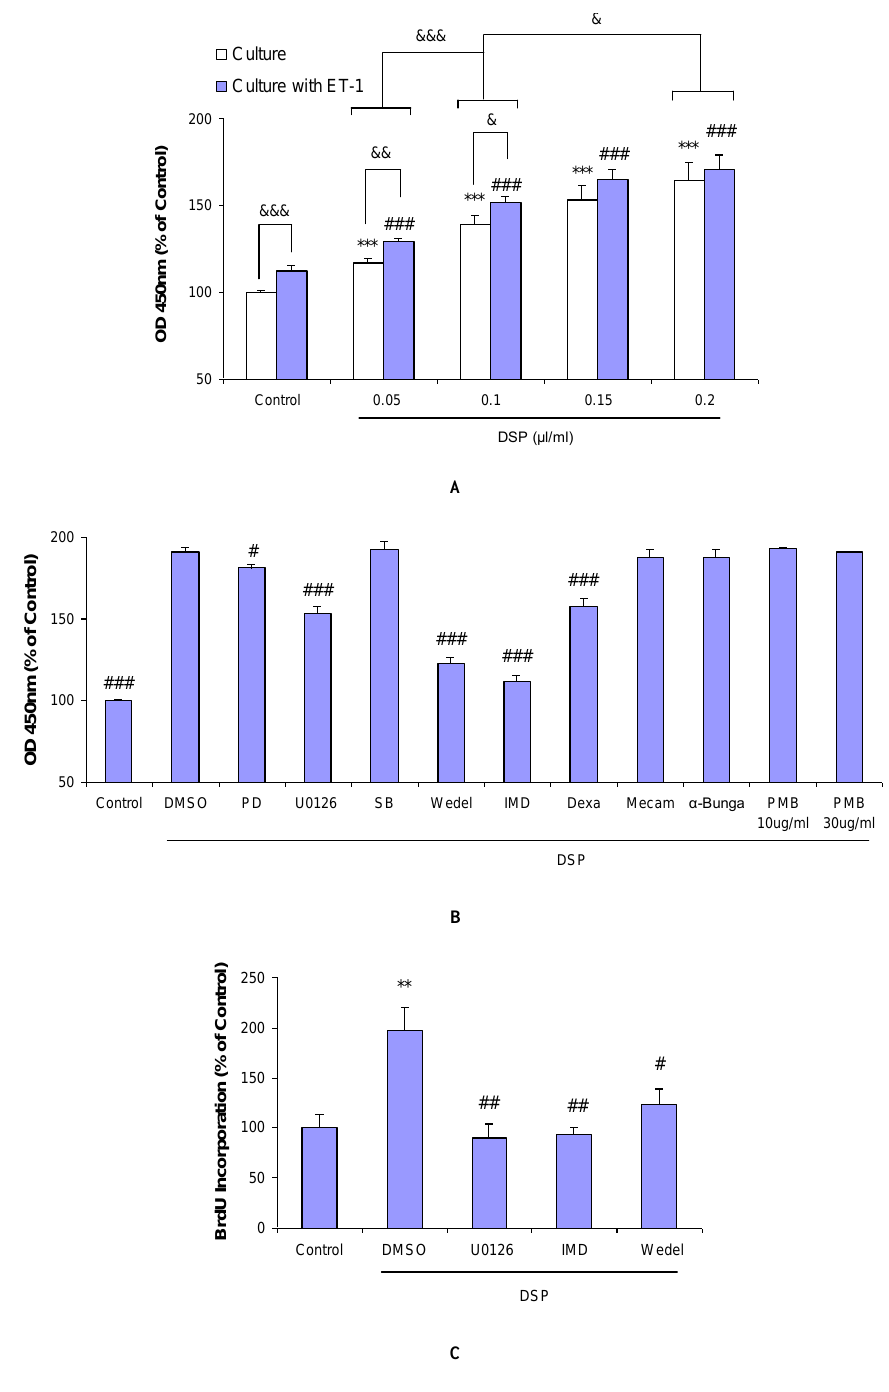
FIGURE 1. DSPs promote cell proliferation through activation of ERK1/2 and NF-κB in human VSMCs. Cultured HASMCs were starved for 24 h in serum-free medium and then different concentrations of DSPs were added for 48 h. 10 μM of PD98059, 10 μM of U0126, 10 μM of SB203580, 5 μM of wedelolactone, 30 nM of IMD-0354, 1 μM of dexamethasone, 10 μM of mecamylamine, 1 μM of α-bungarotoxin, and 10 or 30 μg/ml of polymyxin B were added to cells 30 min prior to treatment with 0.2 μl/ml of DSPs. (A) Bar graphs show concentration-dependent cell proliferation effect of DSPs (from 0.05 to 0.2 μl/ml) as determined by cell proliferation assay; 20 nM of ET-1 was added to cells after 30 min of treatment with DSPs. (B) Bar graphs show the effects of inhibitors on DSP-induced cell proliferation as determined by cell proliferation assay. (C) Bar graphs show the effects of inhibitors on DSP-induced BrdU incorporation. Data represent mean ± S.E.M. ** p < 0.01, *** p < 0.001 vs. control; ### p < 0.001 vs. control of culture with ET-1 (A); # p < 0.05, ## p < 0.01, ### p < 0.001 vs. DMSO (B,C); & p < 0.05, && p < 0.01, &&& p < 0.001; PD = PD98059; SB = SB203580; Wedel = wedelolactone; IMD = IMD-0354; Dexa = dexamethasone; Mecam = mecamylamine; α-Bunga = α-bungarotoxin; PMB = polymyxin